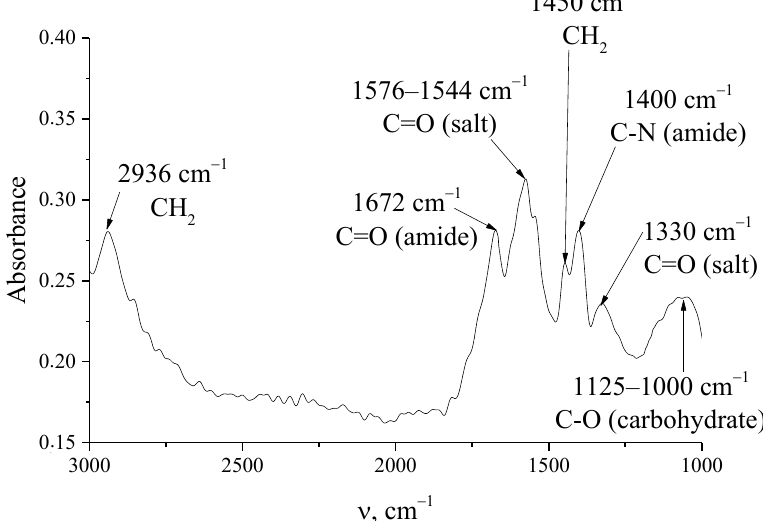
Figure 1. Infrared spectrum of ACP#.